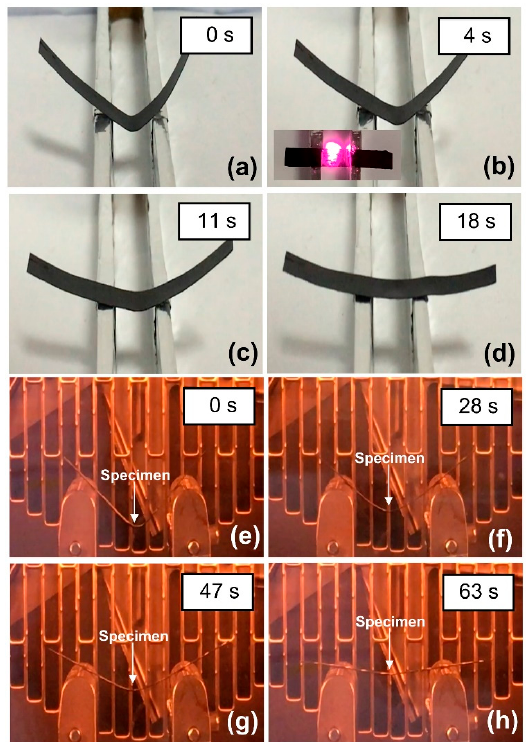
Figure 12. Snapshots of shape recovery process of MWCNT reinforced V-fa/ECO composite at 0.3 wt% of MWCNTs under ( a – d ) NIR-actuation and ( e – h ) thermal heating.